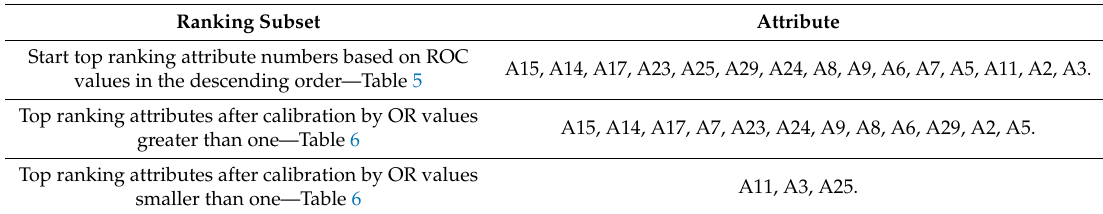
Table 7. Top ranking feature subsets.